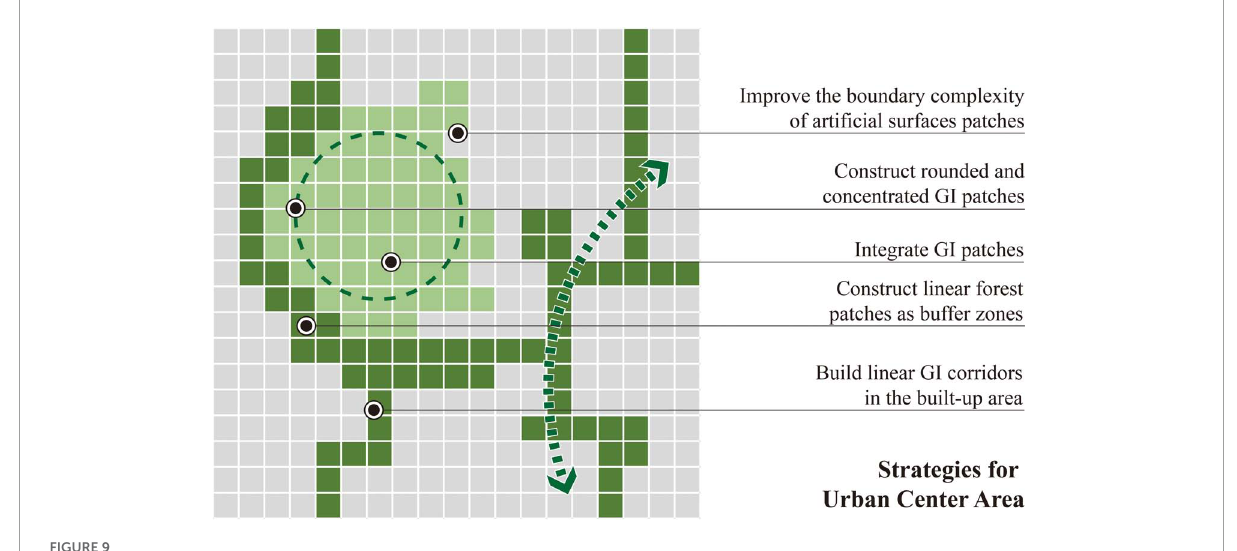
FIGURE9 Strategies for urban center